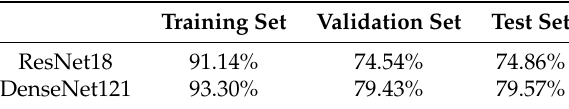
Table 2. Multi-label tagging performance (mean